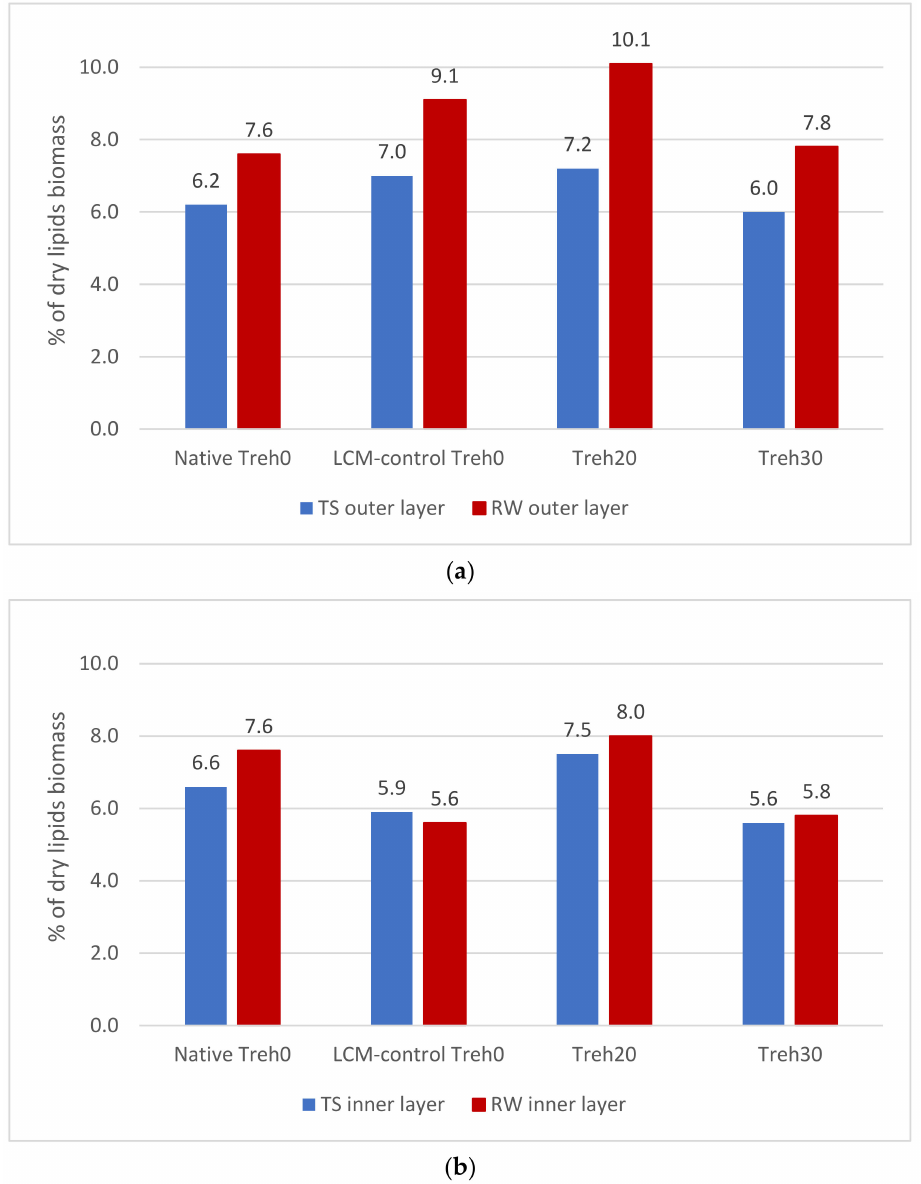
Figure 3. The content of phospholipids of the outer (phosphatidylcholines, sphingomyelins) and inner (phosphatidylethanolamines, phosphatidylserines) layers plasma membrane (% from dry lipids biomass) of native and frozen/thawed spermatozoa (Tsarskoselskaya and Russian White breeds): ( a ) outer layers phospholipids of native and frozen/thawed spermatozoa; ( b ) inner layers phospholipids of native and frozen/thawed spermatozoa. The sum of phospholipids of the inner and outer layers of the plasma membranes of native spermatozoa differs little — 6.2% and 6.6%,